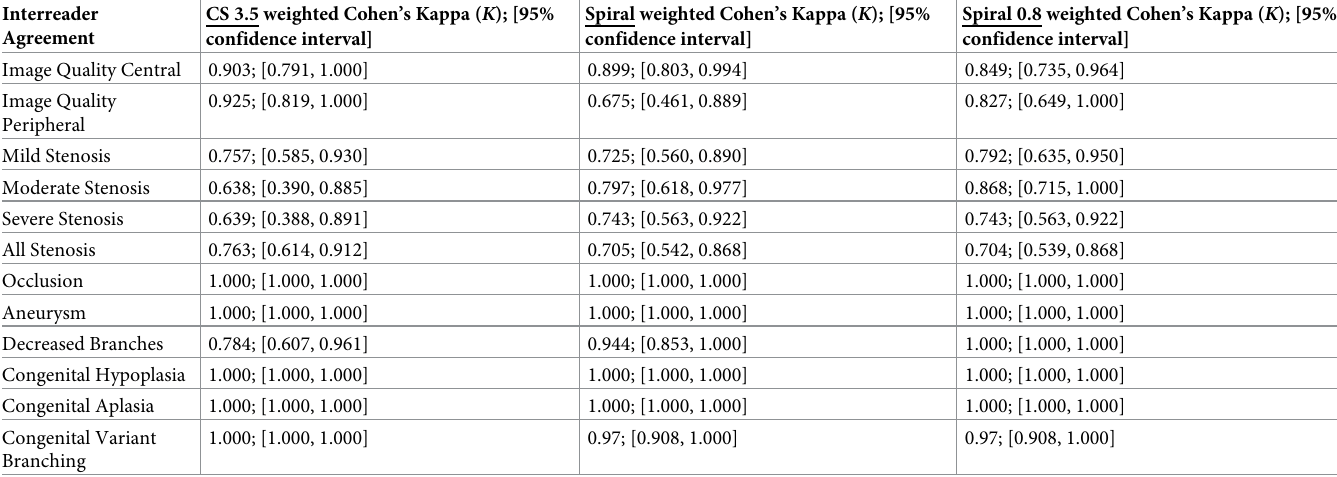
Table 4. Overview of the interreader agreement from qualitative image quality and lesion and variation assessment. Interreader CS 3.5 weighted Cohen’s Kappa ( K ); [95% Agreement confidence interval]